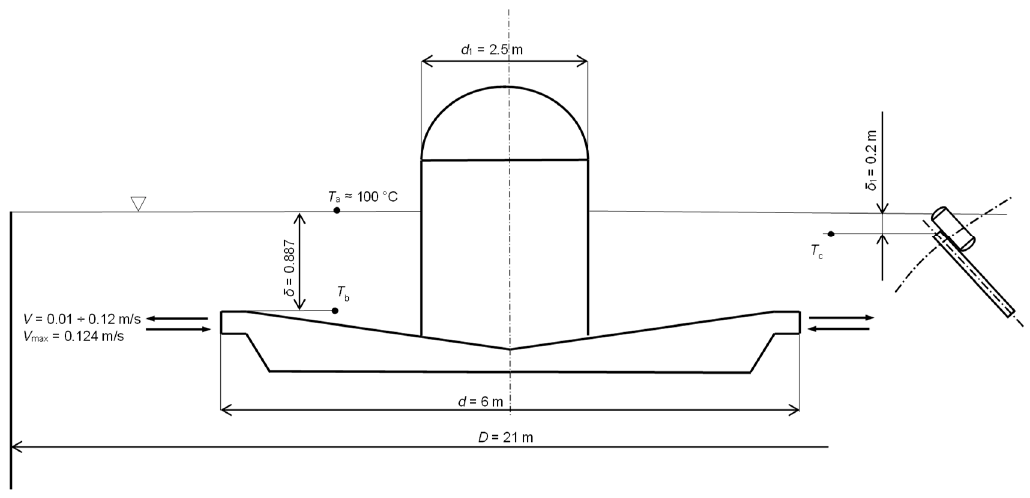
Figure 5. Operational parameters of the SC system in the TES tank in the CHP Bia ł ystok.